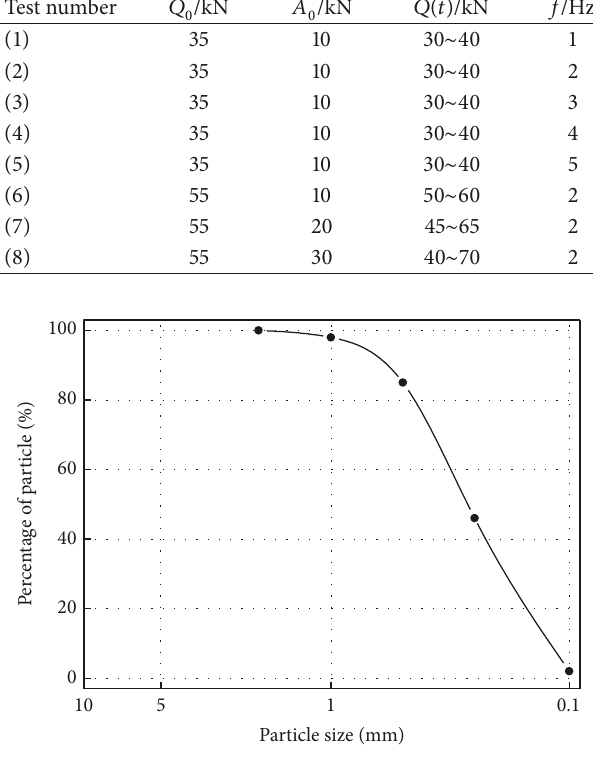
Figure 4: Curve of sand gravel test.